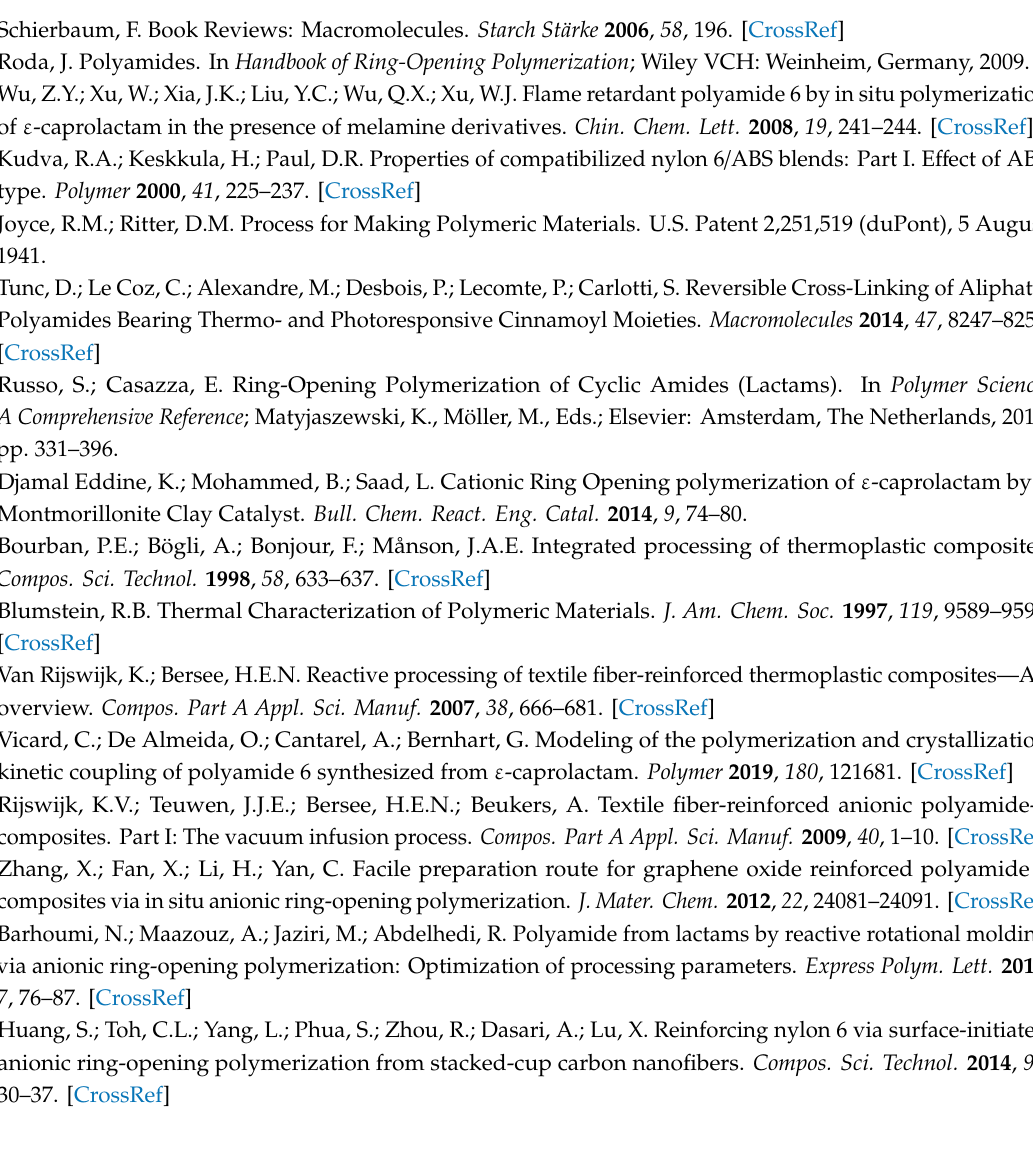
Figure S1: Isothermal crystallization exotherms of neat PA6 and for the glass and carbon fiber composites, Table S1: Data obtained using Avrami